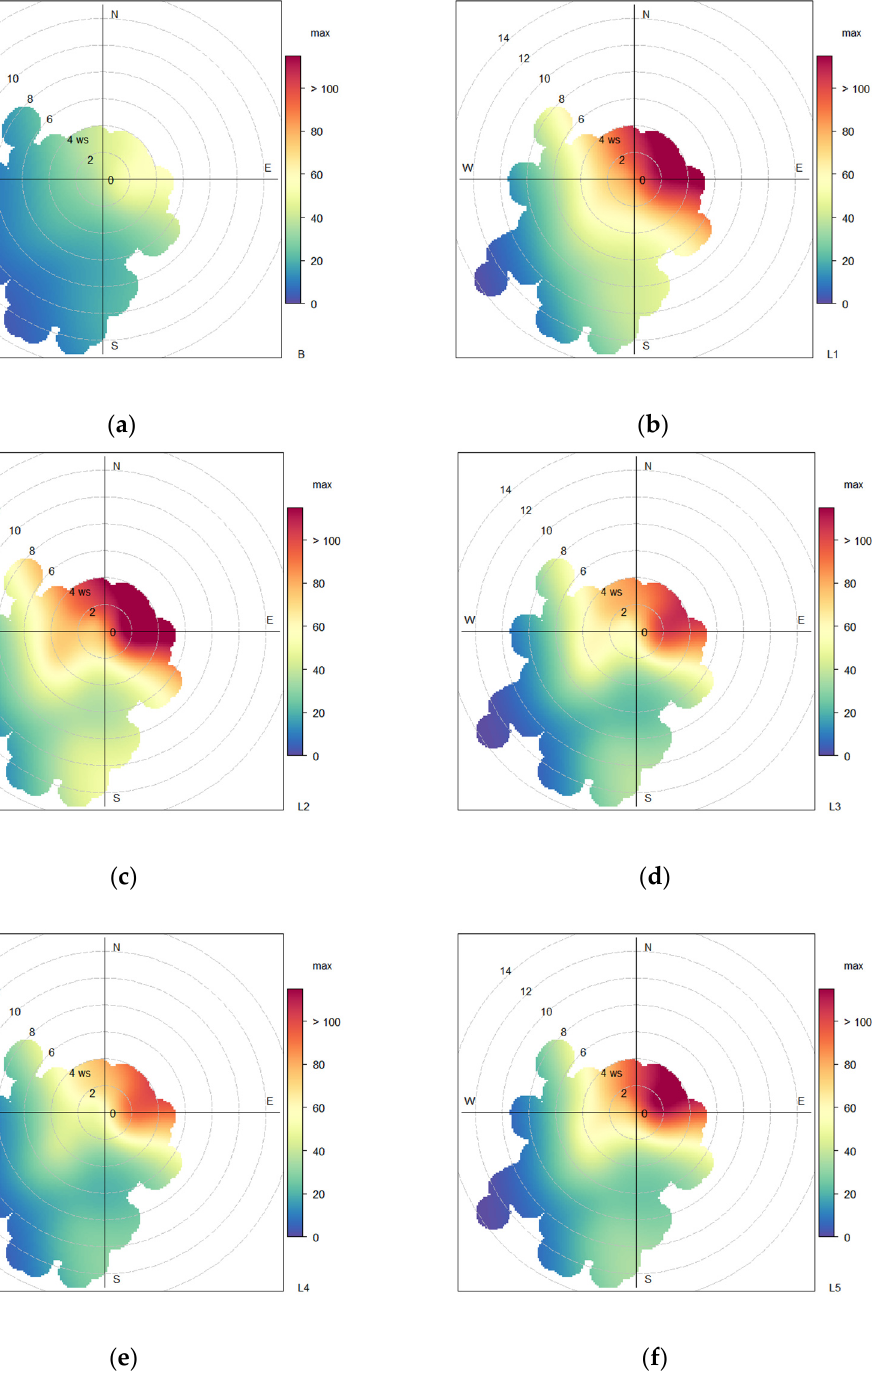
Figure 9. Polar plots for the maximum recorded hourly average concentration of PM 10 (in μ g/m 3 ) for the urban background ( a ), and for individual locations ( b ) L1, ( c ) L2, ( d ) L3, ( e ) L4, ( f ) L5. Figure generated using openair package [38].